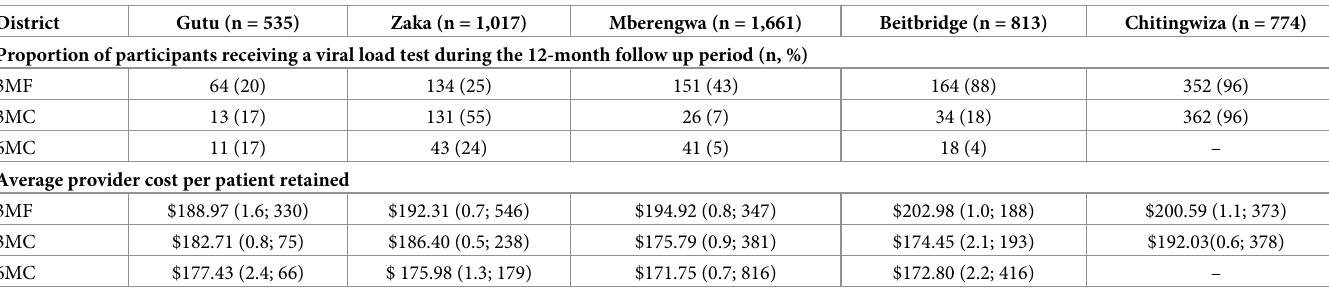
Table 3. District level viral load utilization and provider